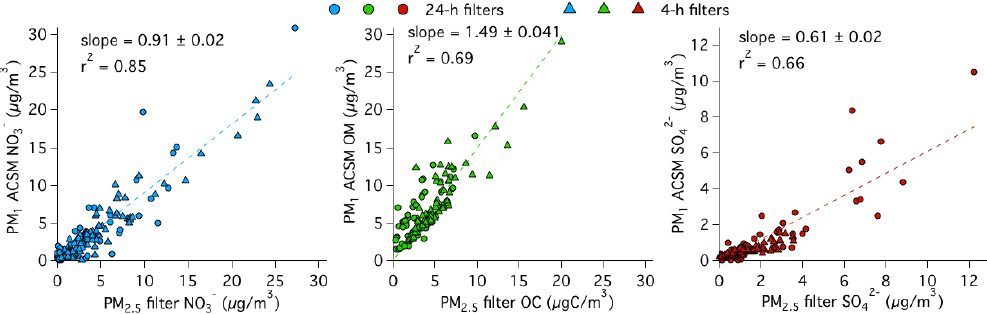
Figure 2. Scatterplot of chemically speciated ACSM measurements versus filter analyses for nitrate, organic matter (compared to OC filter- based measurements) and sulfate.